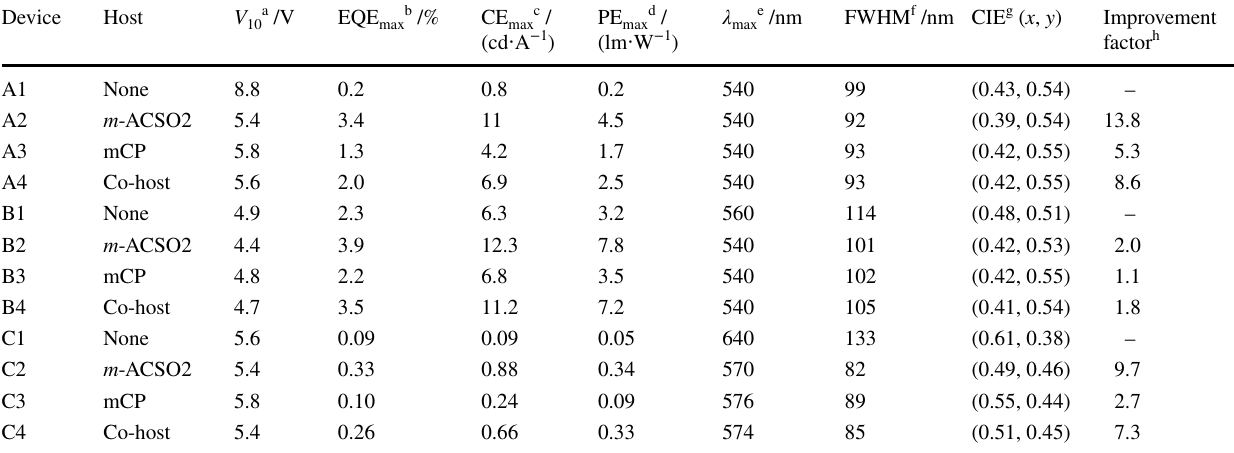
Table 1 Comparison of the EL performances of the devices